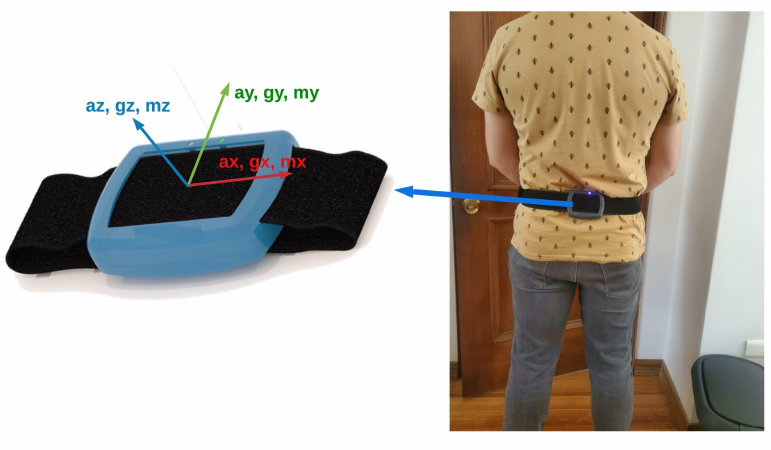
Figure 3. Sensor location for human movement analysis. The sensor is located to deliver their positive measurements in movements according to the axis.